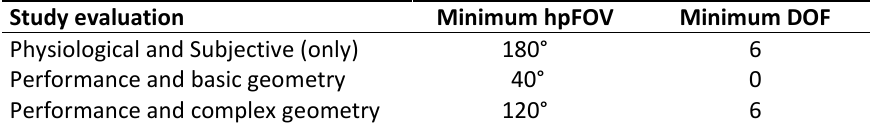
Table 2 . Study´s analyzed variables and simulator minimum characteristics